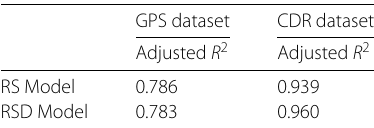
Table 4 Variation in entropy explained by each of the proposed regression models (adjusted R 2 ) for both of our datasets, in the next-cell prediction task. The RS model is the model that uses regularity and stationarity, and the RSD model is the one where diversity of trajectories is also used, along with regularity and